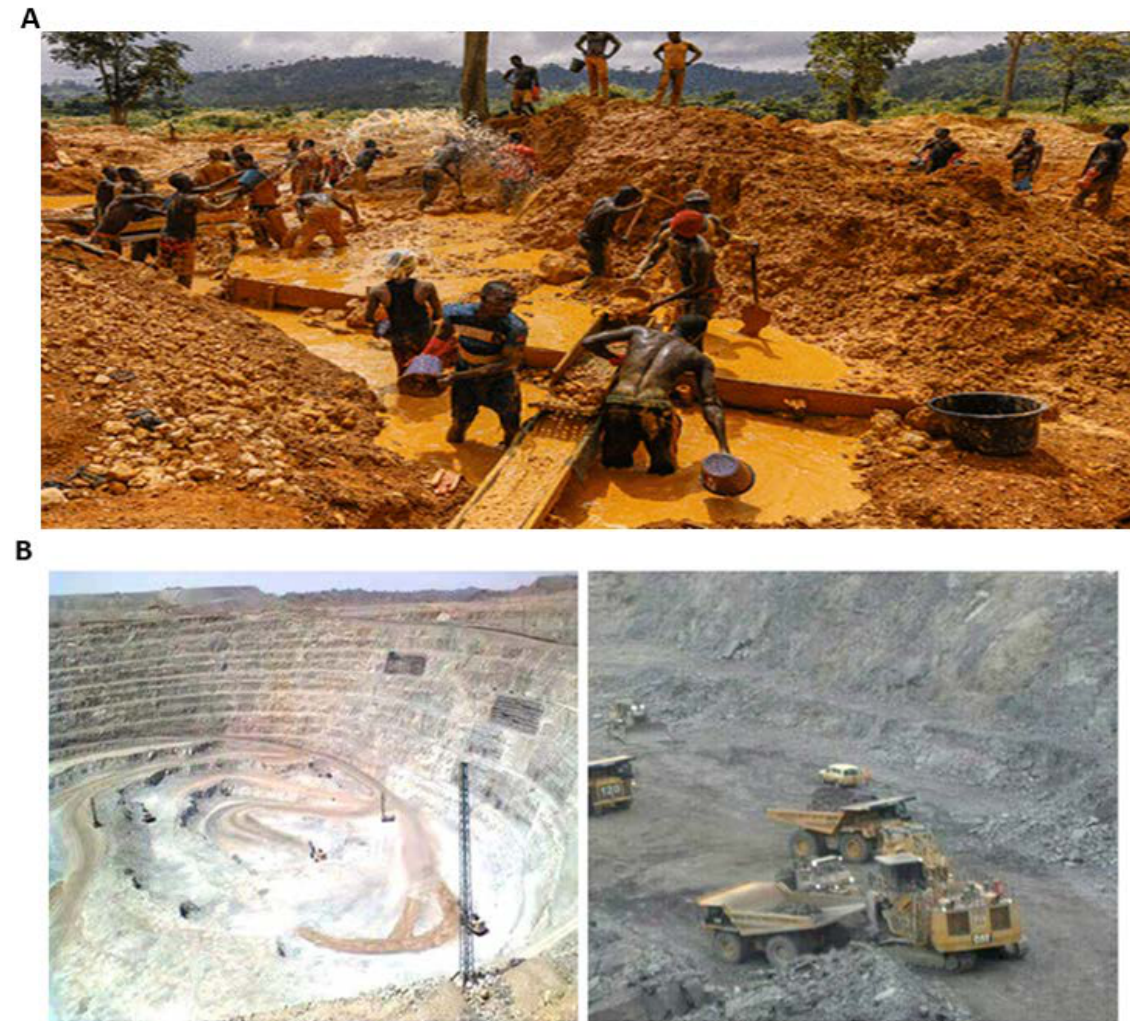
Figure 1. ( A ) Small-scale (galamsey) mining activities, ( B ) large-scale surface mining activity, August (2020).